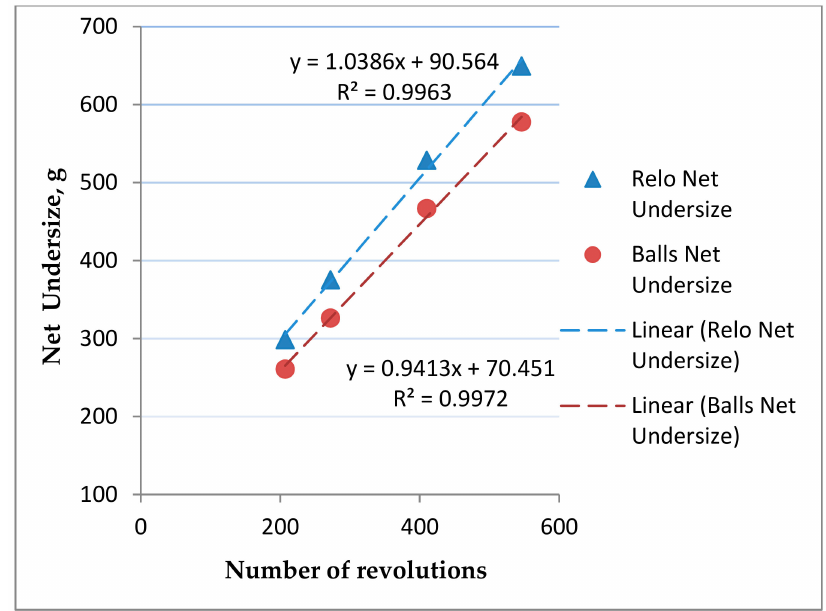
Figure 4. Grinding tests at different CLR—net undersize vs. number of